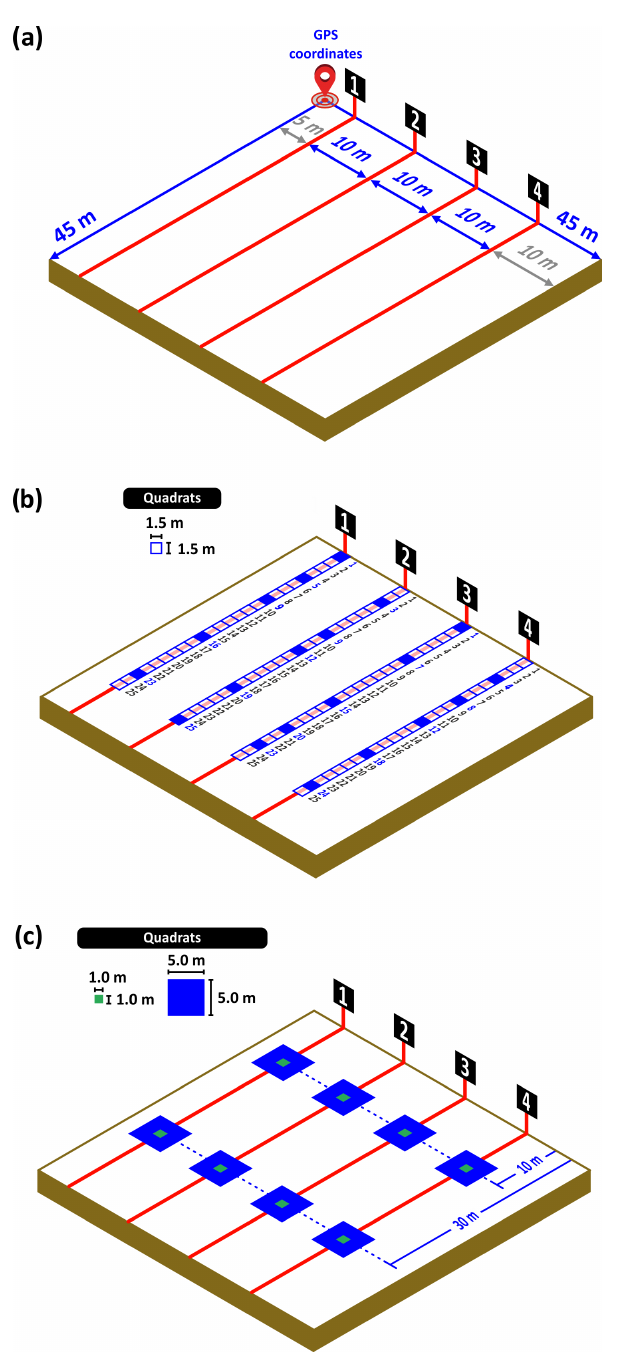
Figure 4. (a) Scheme of a 45m × 45m plot surveyed in the field and of the placement of the transects for the survey of vegeta- tion. (b) Placement of the quadrats in the transects within the plot (25 consecutive quadrats per transect, 100 per plot). The blue- colored quadrats are those used for sampling plant functional traits within the transects. (c) Layout of the quadrats for counting pellet- s/dungs when large (blue quadrats, 5m × 5m size) or small (green quadrats, 1m × 1m size) grazers are present. The numbers 1, 2, 3 and 4 denote the points where measurements of slope and aspect are